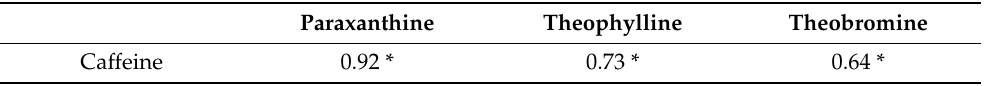
Table 5. Correlation coefficients ( r ) calculated for the relationships between the content of caffeine and its metabolites ( r marked by * are statistically significant at p < 0.05).